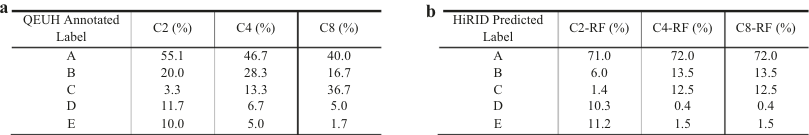
Fig. 6 QUEH annotations across the highly learnable expert-labelled datasets and resulting RF predicted label distributions. a Annotation distributions across the QEUH labelled datasets for C2, C4 & C8. b Predicted label distributions generated by classi fi ers C2-RF, C4-RF & C8-RF when run on the HiRID validation dataset.